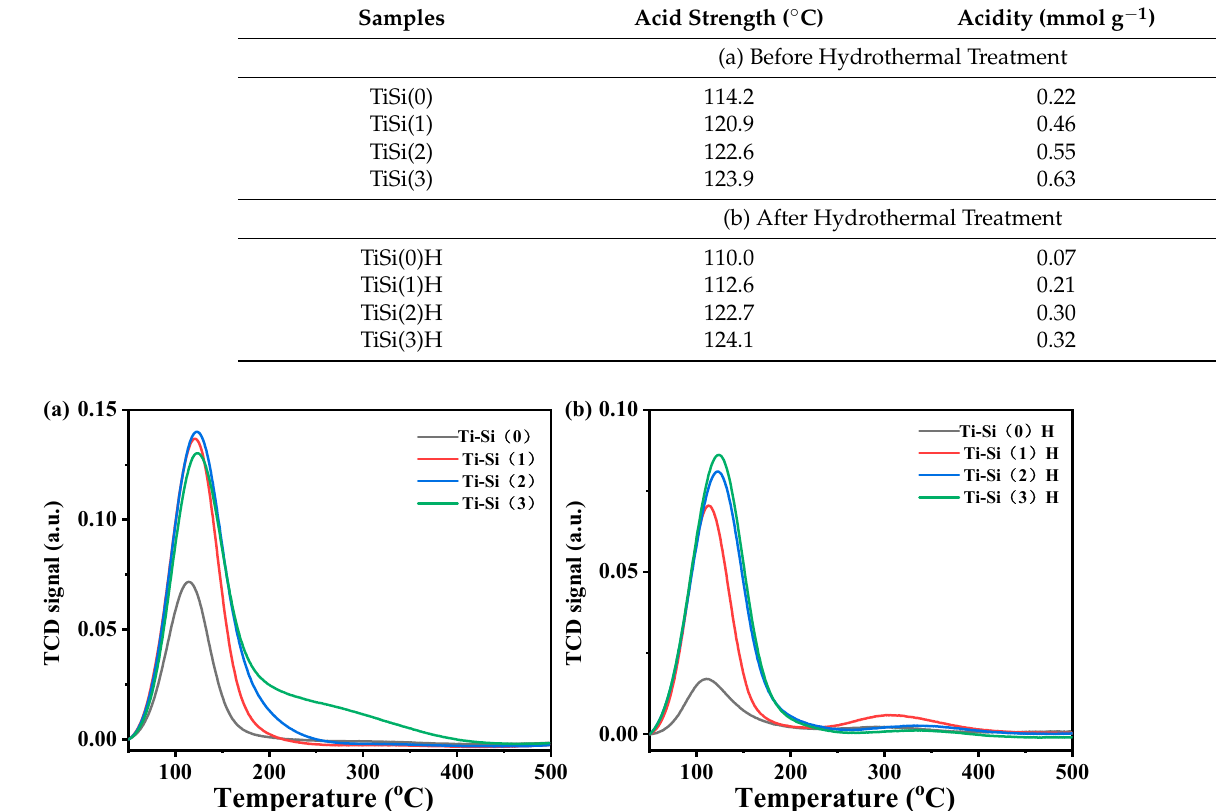
Figure 2. NH 3 -TPD curves of mesoporous silica catalysts with different Ti contents: ( a ) before hydrothermal treatment, ( b ) after hydrothermal treatment. Table 3. NH3-TPD characterization results of mesoporous silica catalysts with different titanium contents ( a ) before hydrothermal treatment, ( b ) after hydrothermal treatment.